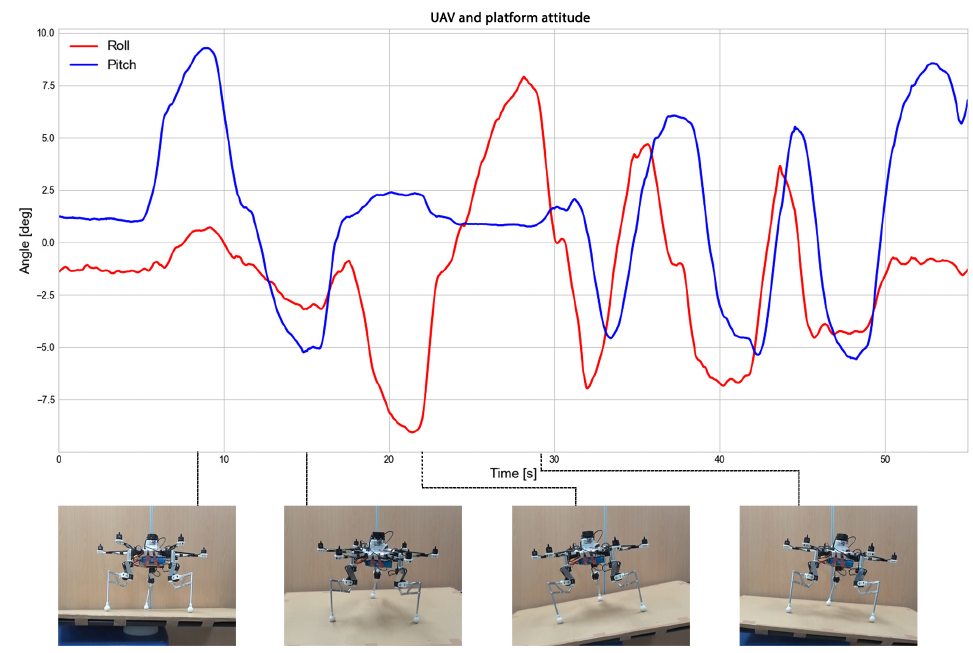
Figure 10. Roll and pitch angles of the UAV and platform attitude during the experiment without leveling control against surface slope